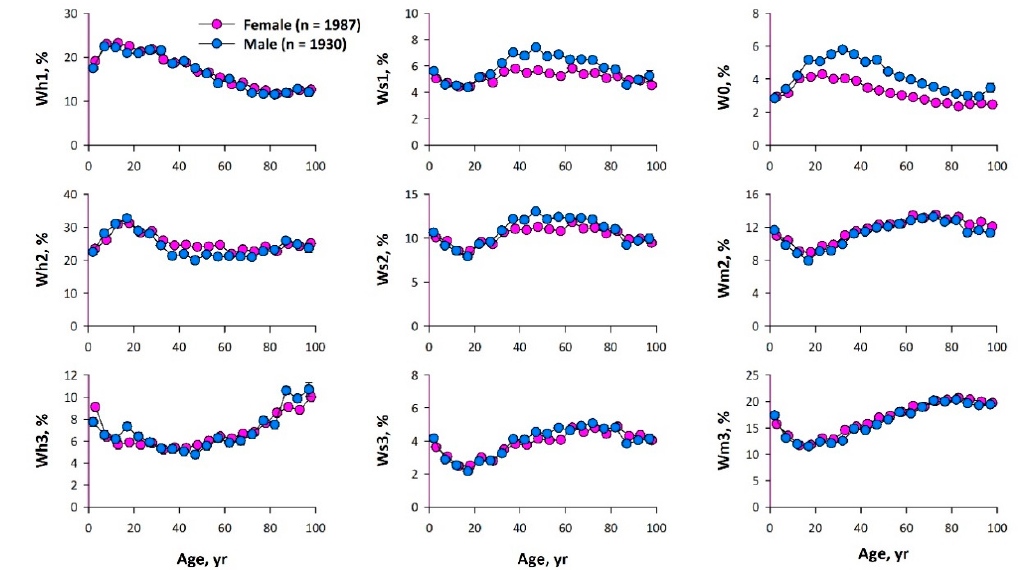
Figure 7. Age and sex dependency of the percentage of hard and soft inflection points (PIPh and PIPs). PIPh+s = PIP calculated for both hard and soft inflection points.